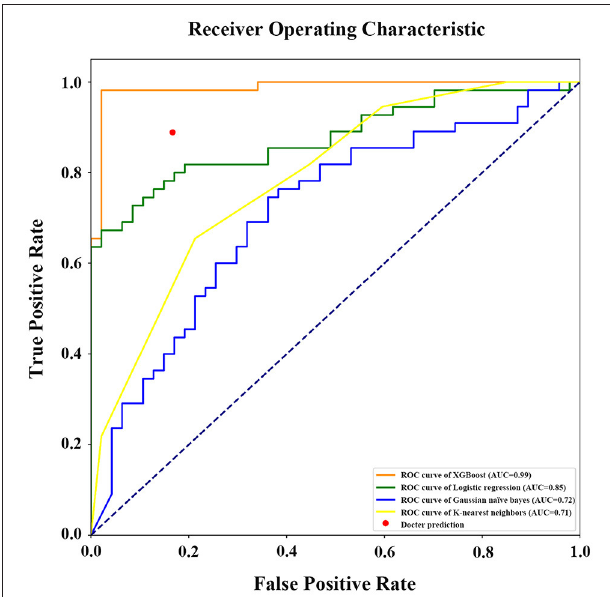
FIGURE 6 | Receiver operating characteristic (ROC) curve with area under curve calculation (legend) of the different models in prediction of RBCs transfusion (binary classifications). AUC, the area under the receiver operating characteristic